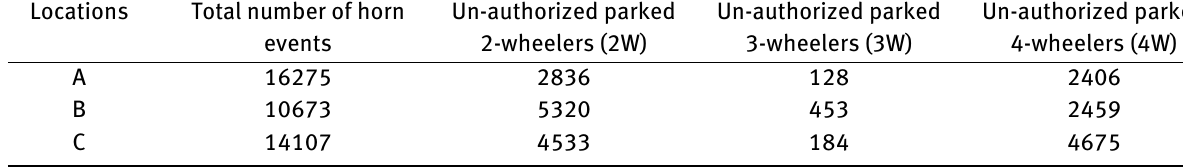
Table 4: Number of horn and un-authorized parked vehicles of Central zone of Surat city Locations